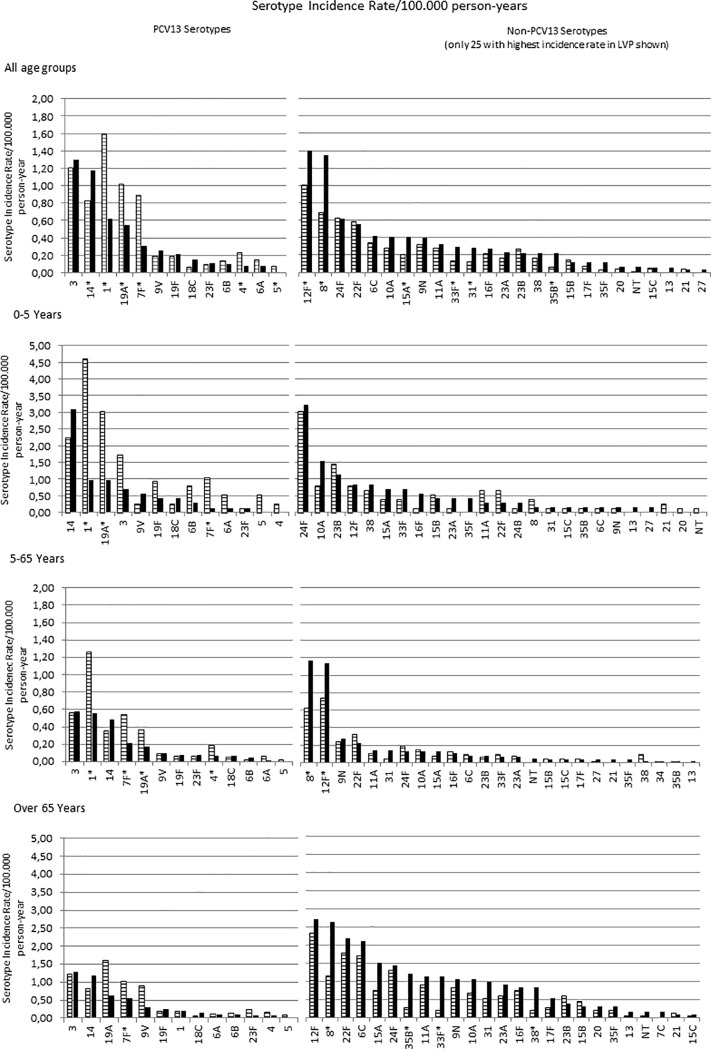
Serotype distribution and incidence rate/100.000 person-years of invasive serotypes during the study period.EVP, early vaccine period; LVP, late vaccine period; NT, non-typable. Filled bars depict EVP, while stripped ones LVP.* p<0.05 (Chi-square test). Despite in the text below we explain serotype distribution results by four age groups, because older children between 5–17 years are the smallest age group (it only includes 91 out of total 2142 IPD episodes), in Fig 2 patients aged from 5 to 65 years have been grouped. Hence, in this figure there are depicted three age groups instead of four.